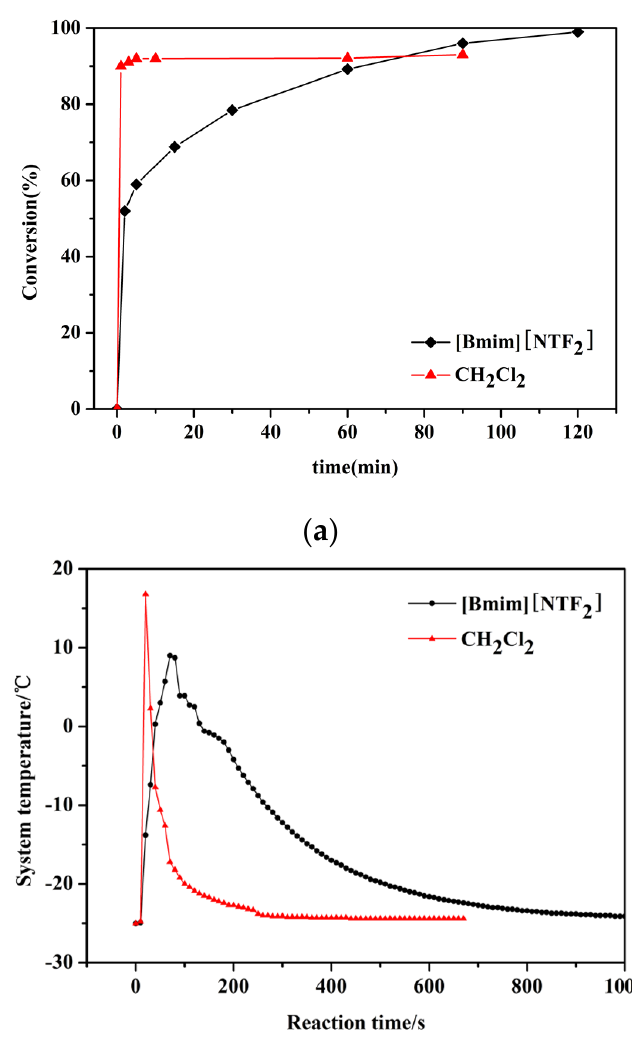
Figure 5. ( a ) Time conversion and ( b ) system temperature time plots for p -MeSt polymerization with p -MeStCl/SnCl 4 in [Bmim][NTf 2 ] and CH 2 Cl 2 at − 25 ◦